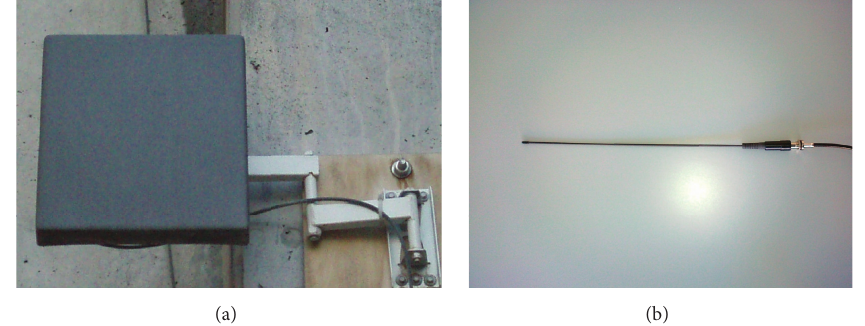
Figure 9: A directional antenna (a) and an omnidirectional antenna (b).